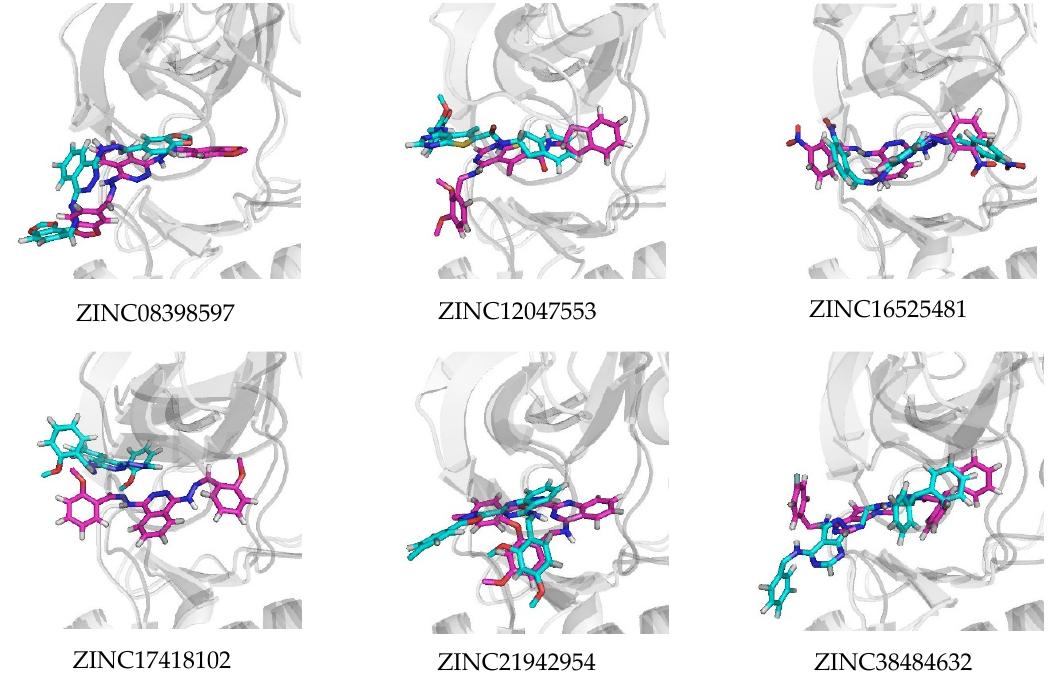
Figure 10. Superimposed ligand binding poses of the potential compounds at 0 ns (magenta) and 50 ns (cyan) in their complex with EGFR.